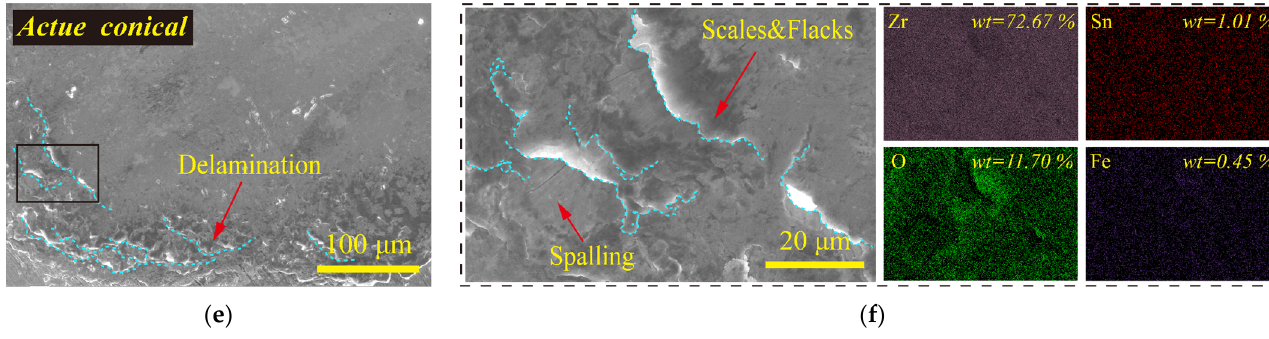
Figure 7. SEM micrographs of wear scar and EDS with different impact block shapes: ( a , b ) hemi- spherical; ( c , d ) obtuse conical; ( e , f ) acute conical.